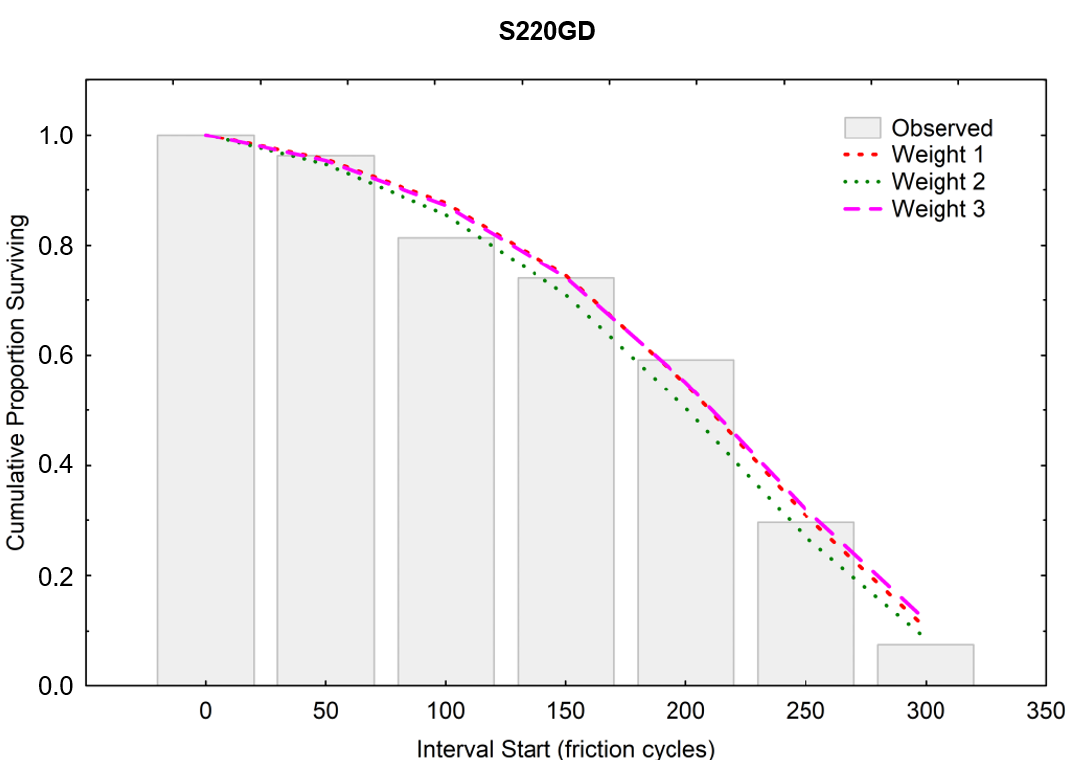
Figure 14. Cumulative proportion surviving (S220 GD).